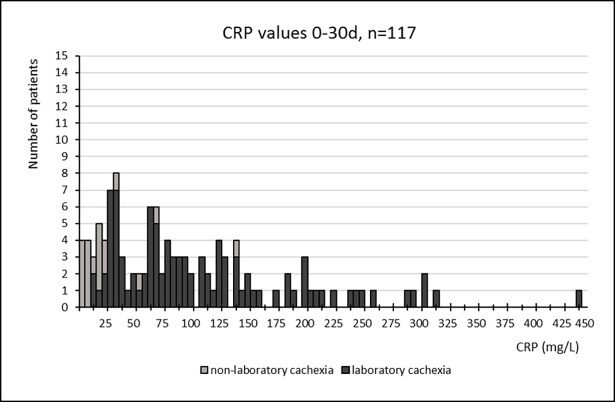
CRP values, 0-30d.CRP values within the 0-30d period for all patients with available measurements for both CRP and s-albumin within this period.